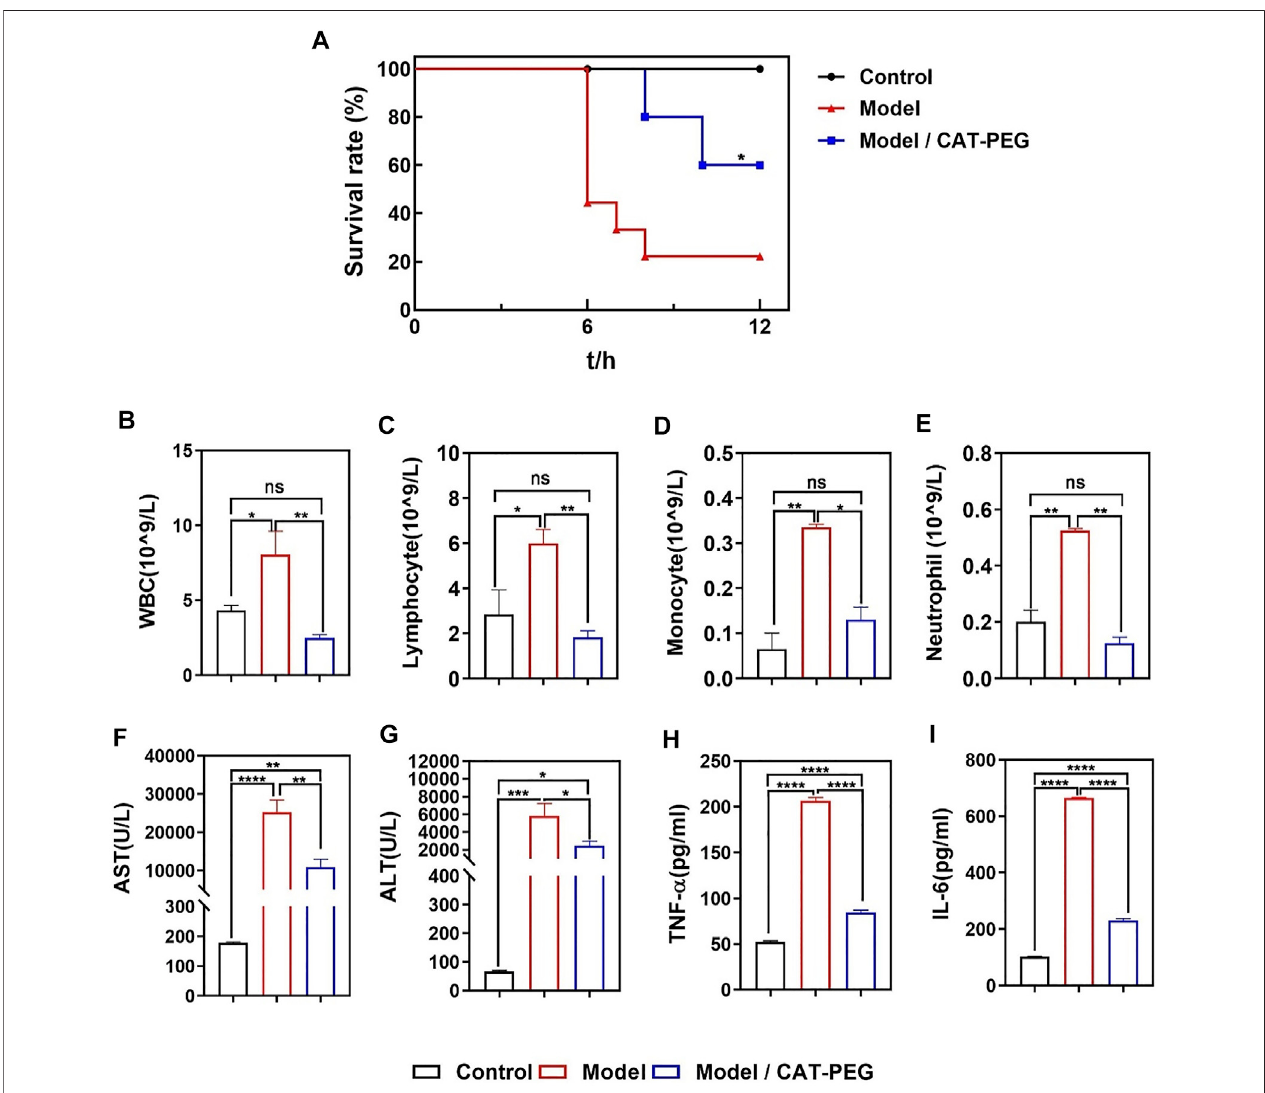
FIGURE 4 | Effectiveness of CAT-PEG treatment in mice with induced sepsis. (A) Survival curve of. the healthy mice (Control group), the mice with induced sepsis (Model group) and the model mice with CAT-PEG treatment (Model + CAT-PEG group). The survival of mice was monitored for 12 h n (cid:2) 9. * p ＜ 0.05 (Log-rank (Mantel- Cox)test). (B – E) countsofwhitebloodcells(WBC),lymphocytes,monocytes,andneutrophils, (F) aspartateaminotransferase(AST), (G) alanineaminotransferase(ALT), (H) TNF- α , (I) IL-6 levels of the control group, model group, and treatment group. n (cid:2) 3. Data represent means ± s.e.m. p value: *p ＜ 0.05, **p ＜ 0.01, ***p ＜ 0.001 and **** p ＜ 0.0001. ns means not signi fi